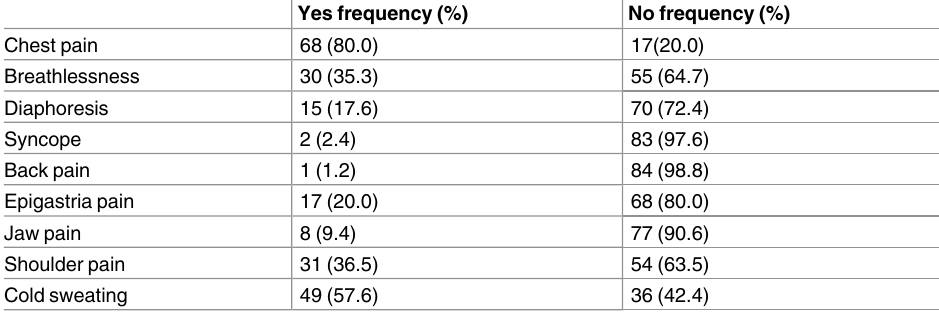
Table 1. The frequency of myocardial infarction symptoms Yes frequency (%)